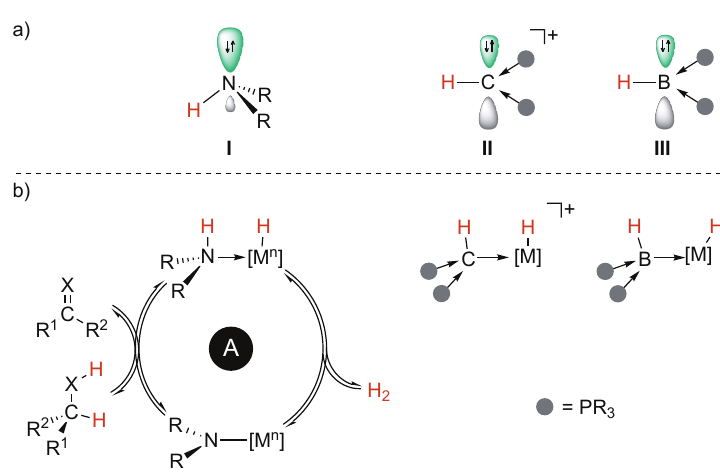
Figure 1. ( a ) Secondary amines ( I ), protonated carbodiphosphoranes ( II ) and phosphine-stabilized borylenes ( III ) in comparison; ( b ) Secondary amine ligands and their role in cooperative catalysis in comparison to the analogous metal complexes with II and III as ligands.